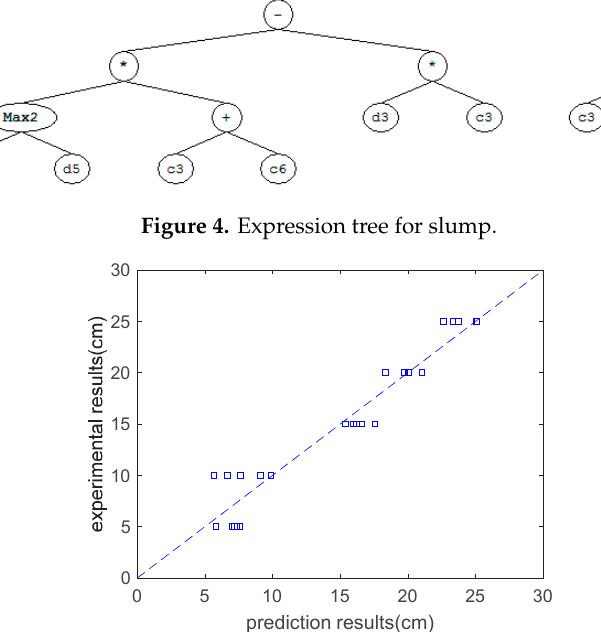
Figure 5. Experimental results vs. prediction results on slump.